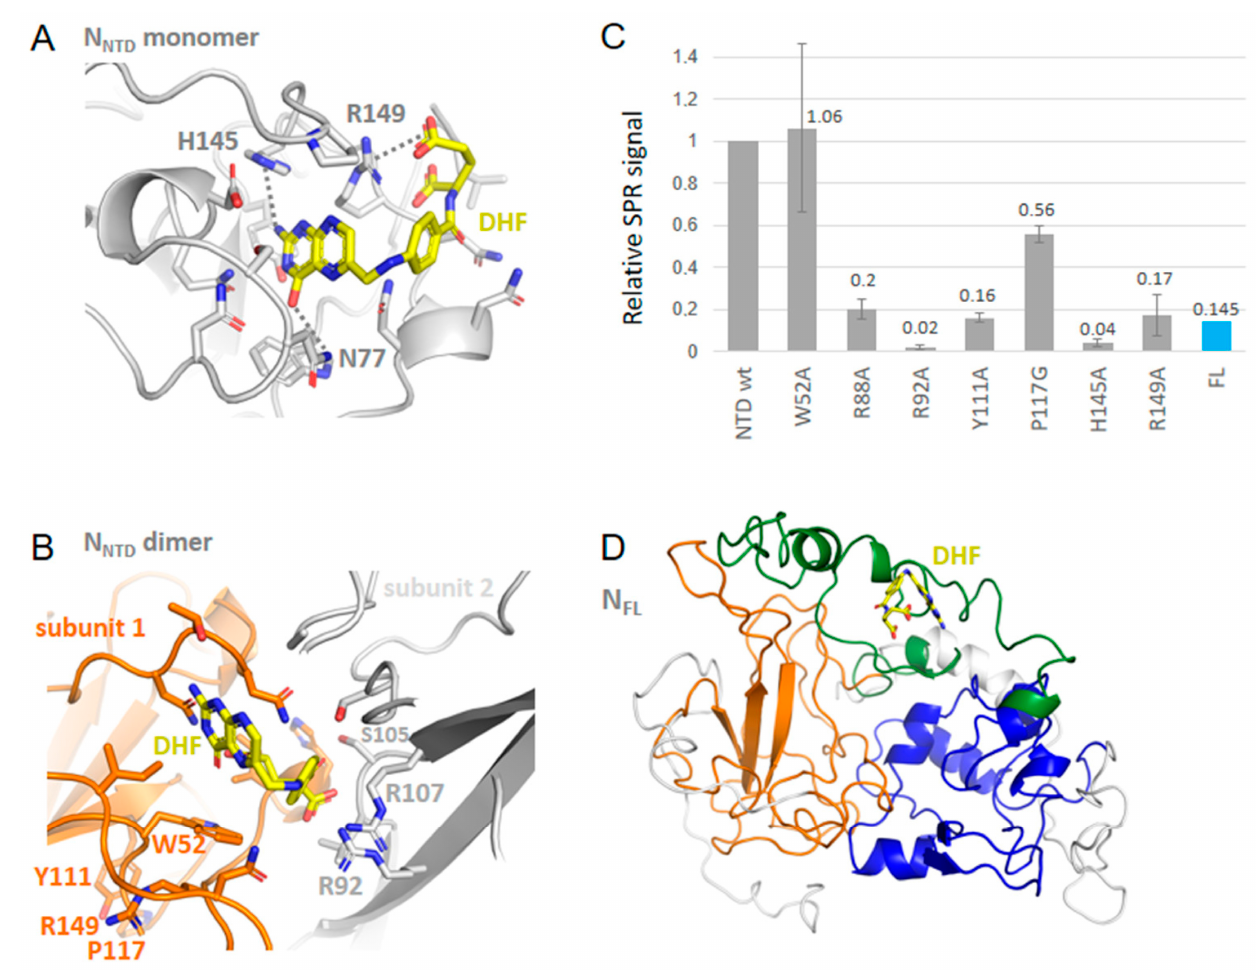
Figure 3. Interactions of N with dihydrofolate DHF. ( A ) Complex of monomeric NTD with DHF shown in yellow based on PDB 7ACT; ( B ) Complex of dimeric NTD with DHF based on PDB 6WYO; note the presence of cation– π interactions in both complexes; ( C ) SPR signal of wt NTD or mutants or of wt FL with DHF (10 µ M) in 20 mM HEPES buffer: note the large decrease of the signal with the H145A and R149A mutants as predicted in A; the decrease with the R88A, R92A, and Y111A mutants with a small decrease in the P117G mutant, are in agreement with the structure in ( B ); ( D ) shows the modeled complex of DHF with FL, also observed in ( C